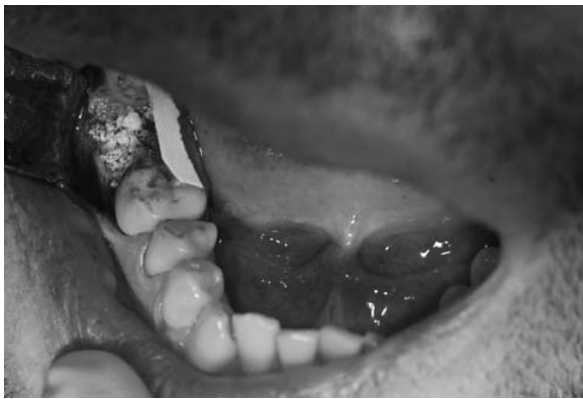
Fig. 1 Bone grafting and the membrane during its placing.